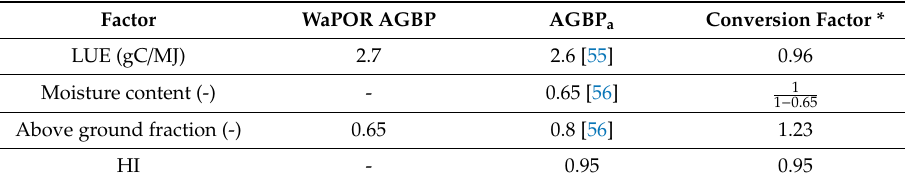
Table 4. Conversion factors used to convert WaPOR dry aboveground biomass productivity (AGBP) to sugarcane for comparison against farmer reported fresh AGBP